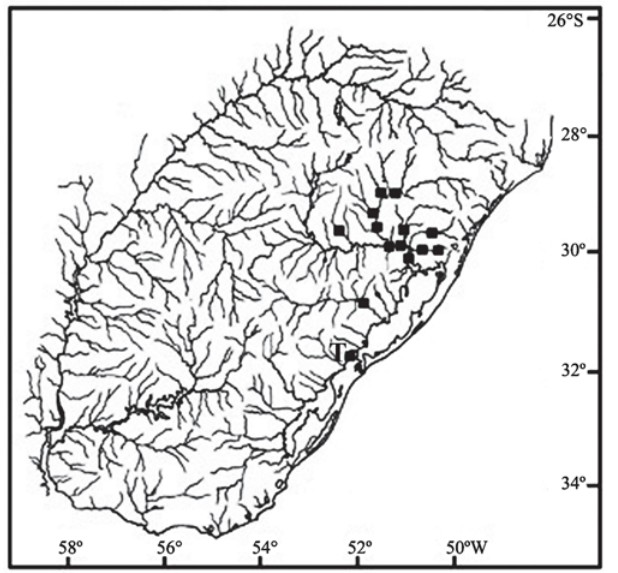
Fig. 6. Map of Rio Grande do Sul, Brazil, and Uruguay showing the distribution of Bunocephalus erondinae . Each square represents one or more collecting localities. “T” indicates the